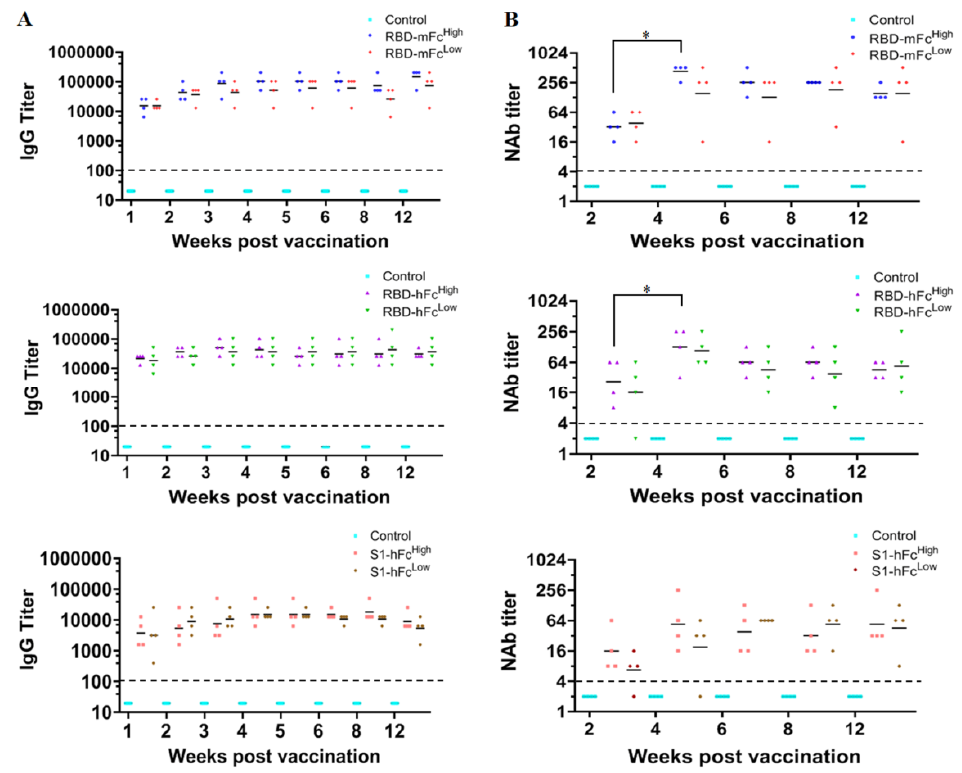
Figure 3. The immunogenicity of recombinant RBD and S1 subunit vaccines. BALB/c mice were immunized with high (8 μ g) or low (2 μ g) doses of RBD-mFc, RBD-hFc and S1-hFc fusion vaccines. Aluminum hydroxide in PBS was used as the negative control. Following a two-dose immunization program, serum samples were collected to assess the humoral immunity. ( A ) ELISA was performed to measure IgG antibody titers. ( B ) The plaque reduction neutralization test (PRNT) was conducted as the neutralization assay, and the neutralization antibody (NAb) titers were calculated as the reciprocal of serum dilutions leading to 50% plaque reductions (PRNT 50 ). The dotted lines meant the detection limit of this assay. * Significant difference between the two groups ( p <